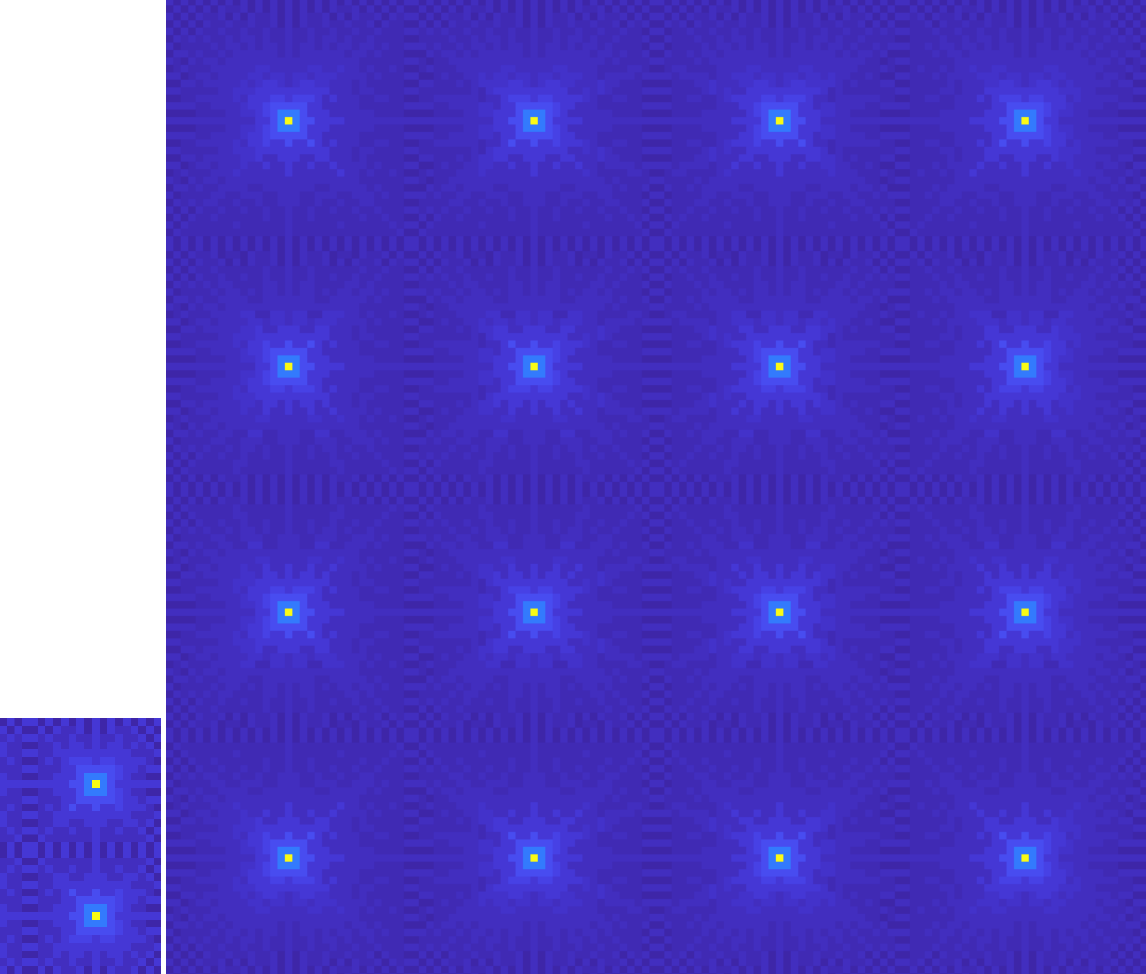
Figure 7. Left , unique impulse responses for size N = 8. Right , the equivalent for N =